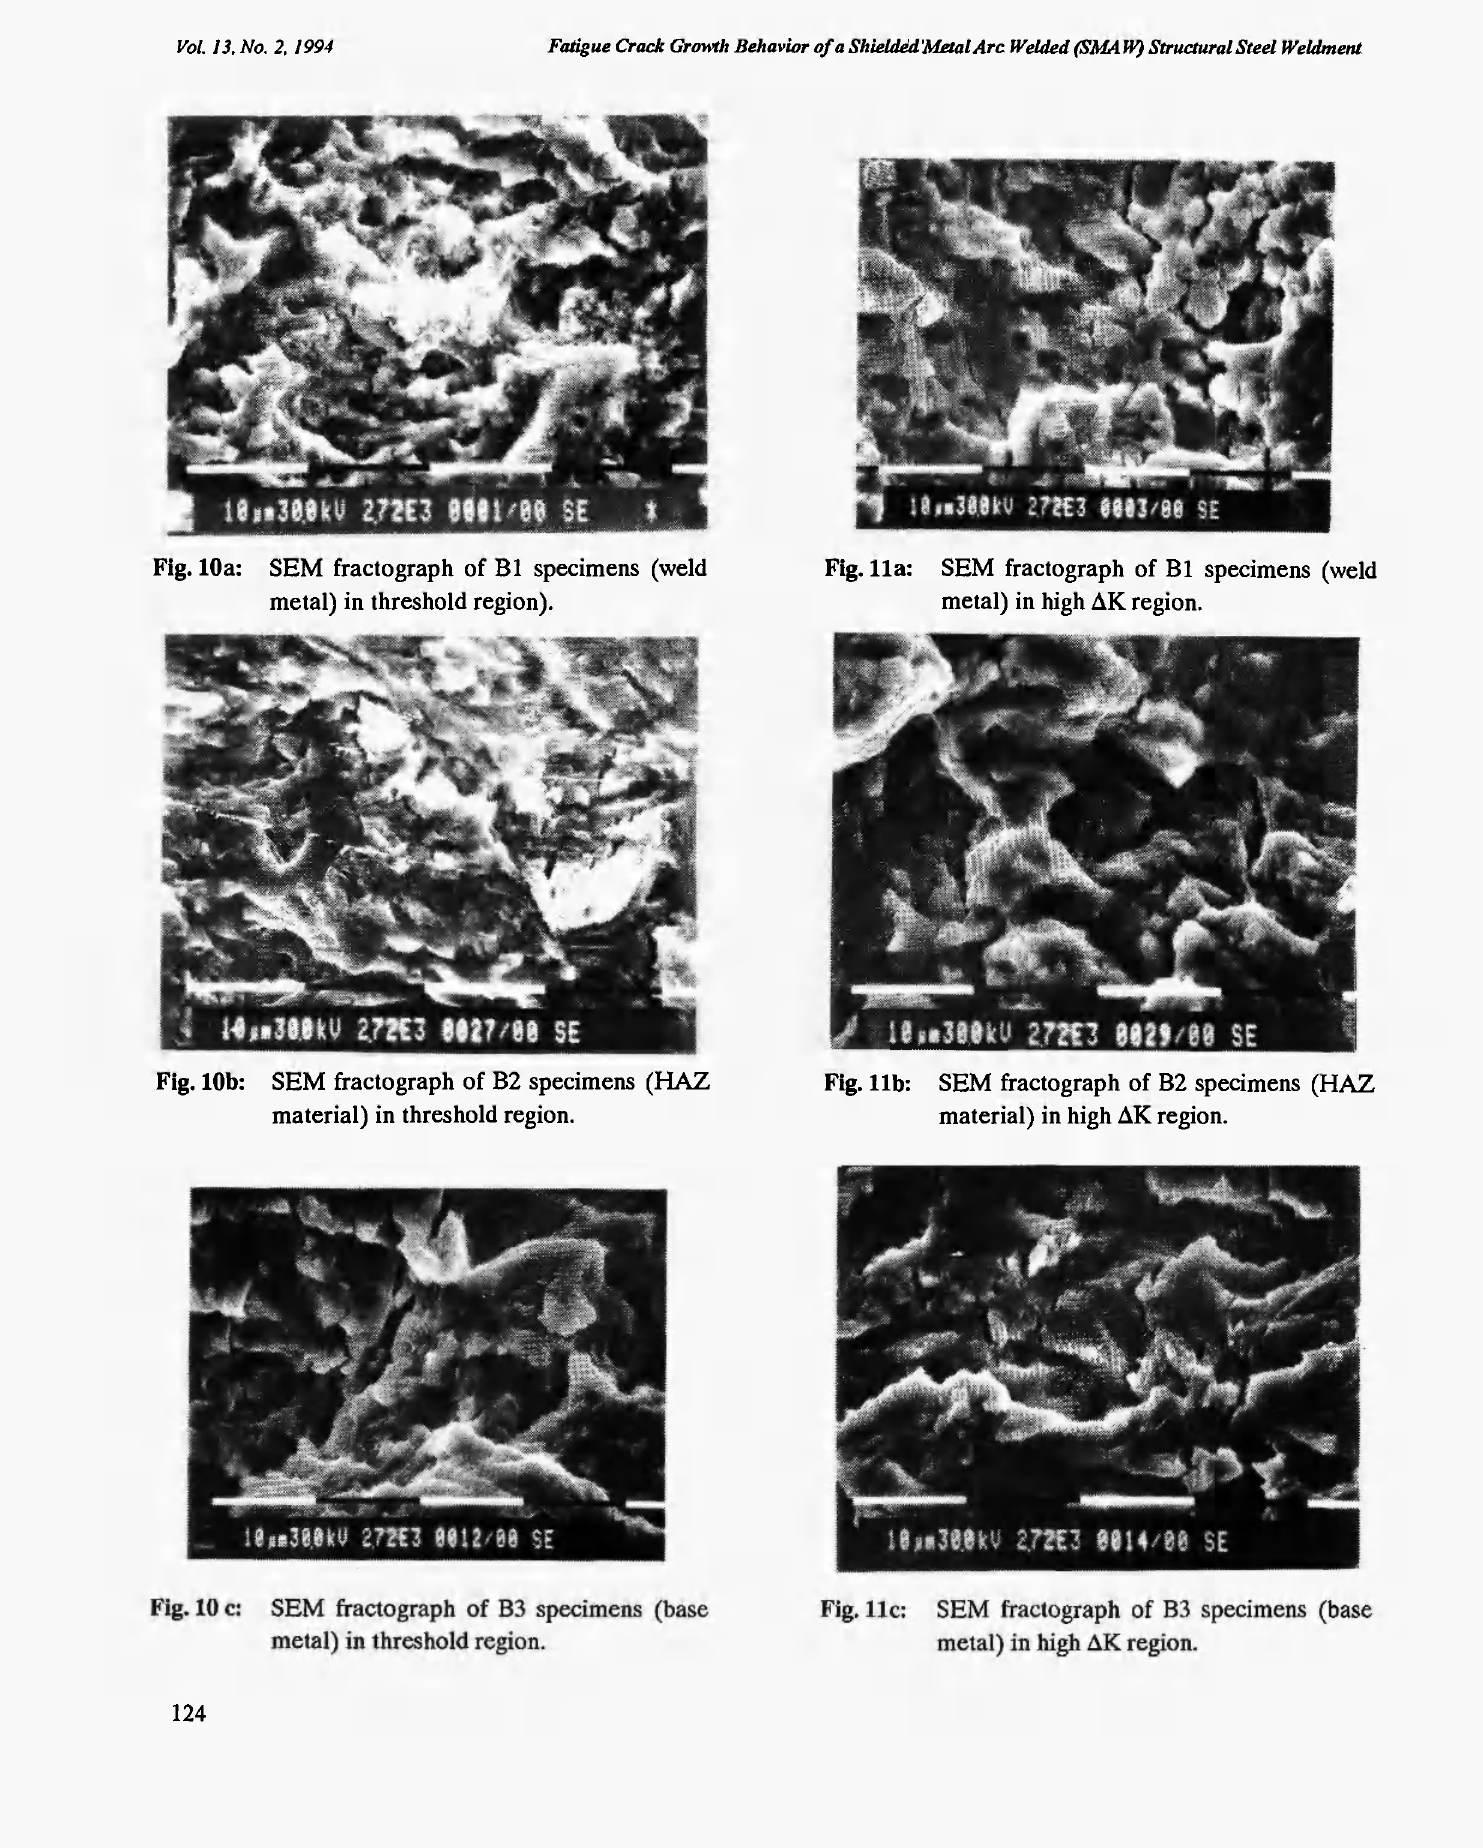
Fig. 10a: SEM fractograph of B1 specimens (weld metal) in threshold region).